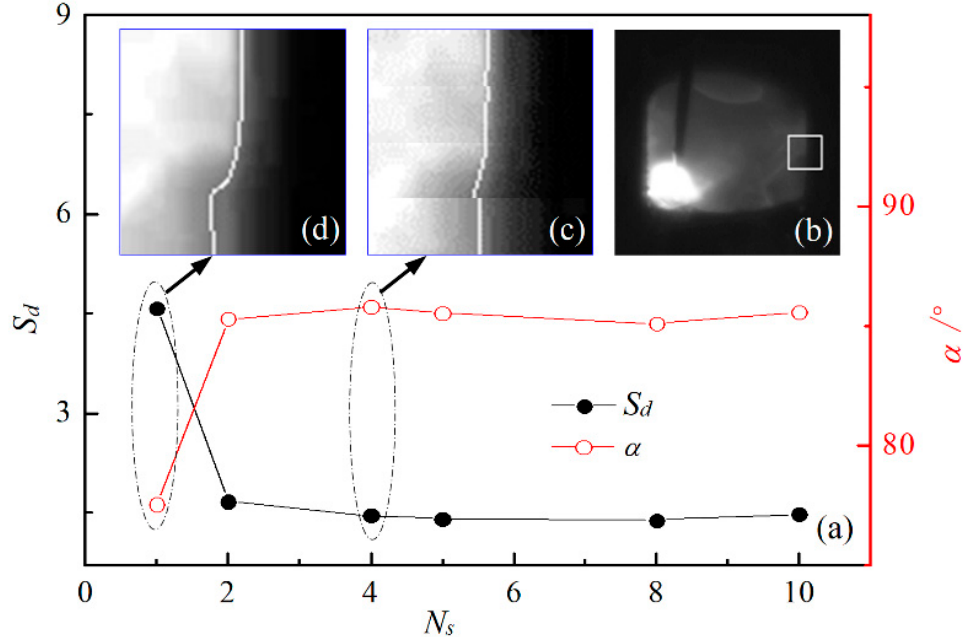
Figure 3. Effect of vertical equal partition number N s of ROI window image on the extraction accuracy of groove edge ( S d is the standard deviation of positional distribution of groove edge points, and α denotes the slope angle of fitting line of groove edge points: ( a ) effect of N s on S d and α ; ( b ) example of ROI window in welding image; ( c ) four partitions of ROI window image; ( d ) single partition of ROI window image.